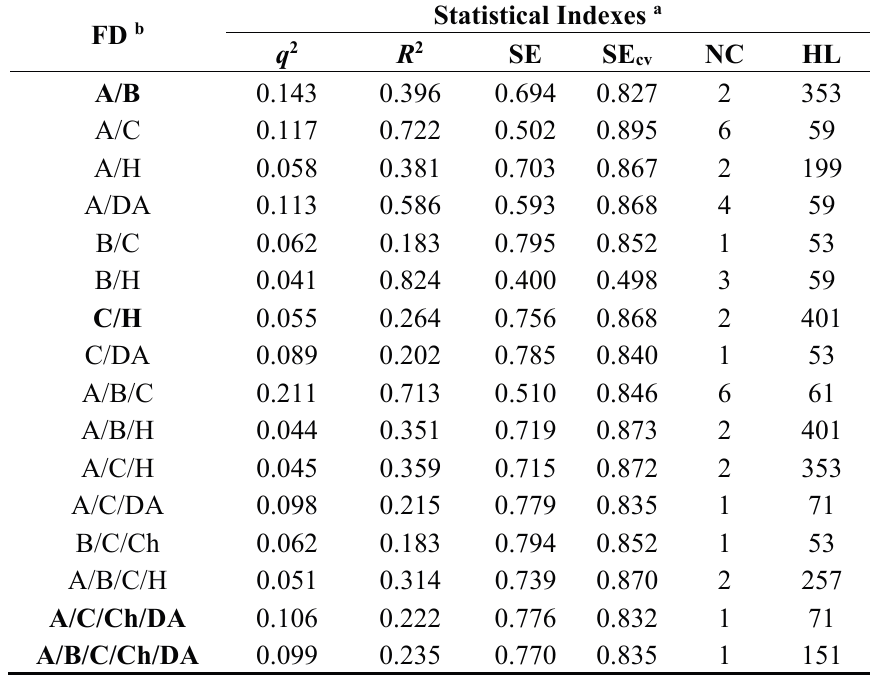
Table 4. Summary of the HQSAR statistical indexes in the Y-randomization test using the default fragment size (4–7 atoms) for the 6-arylquinazolin-4-amine derivatives ( N =